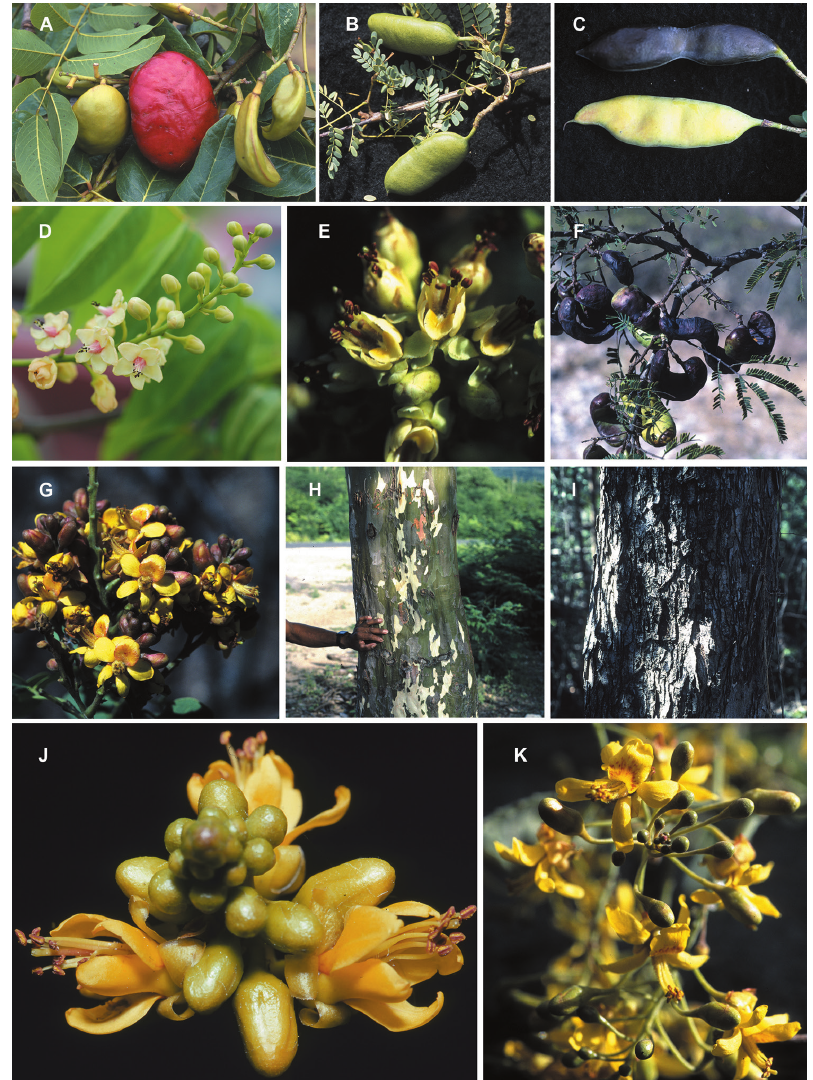
Figure 32. Libidibia monosperma (Tul.) E. Gagnon & G. P. Lewis. A fruits and foliage (M. F. Gardner, Dominican Republic, Gardner & Knees 7027 (E)) D inflorescence (Carlos Pacheco, Wikicommons (https:// commons.wikimedia.org/wiki/File:Stahlia_monosperma_flower_(5840542648).jpg), Puerto Rico, USA, unvouchered ). Libidibia paraguariensis (D. Parodi) G. P. Lewis B unripe fruits (C. E. Hughes, Santa Cruz, Bolivia, Hughes 2475 (FHO)). Libidibia glabrata (Kunth) C. Cast. & G. P. Lewis C fruits K inflores- cence (C. E. Hughes, La Libertad, Peru, Eastwood et al. RJE85 (FHO)). Libidibia coriaria (Jacq.) Schltdl. E flowers (C. E. Hughes, Estelí, Nicaragua, MacQueen 8 (FHO)) F branch with fruits (C. E. Hughes, Metapan, El Salvador, Lewis 1745 (K) ) I bark (C. E. Hughes, Oaxaca, Mexico, Hughes 1933 (FHO)) . Li- bidibia sclerocarpa (Standl.) Britton & Rose, G inflorescence (C. E. Hughes, Oaxaca, Mexico, Lewis 1800 (K)) H bark (C. E. Hughes, Oaxaca, Mexico, Hughes et al. 1494 (FHO)). Libidibia ferrea var. parvifolia (Benth.) L. P. de Queiroz J inflorescence (G. P. Lewis, Bahia, Brazil, unvouchered )